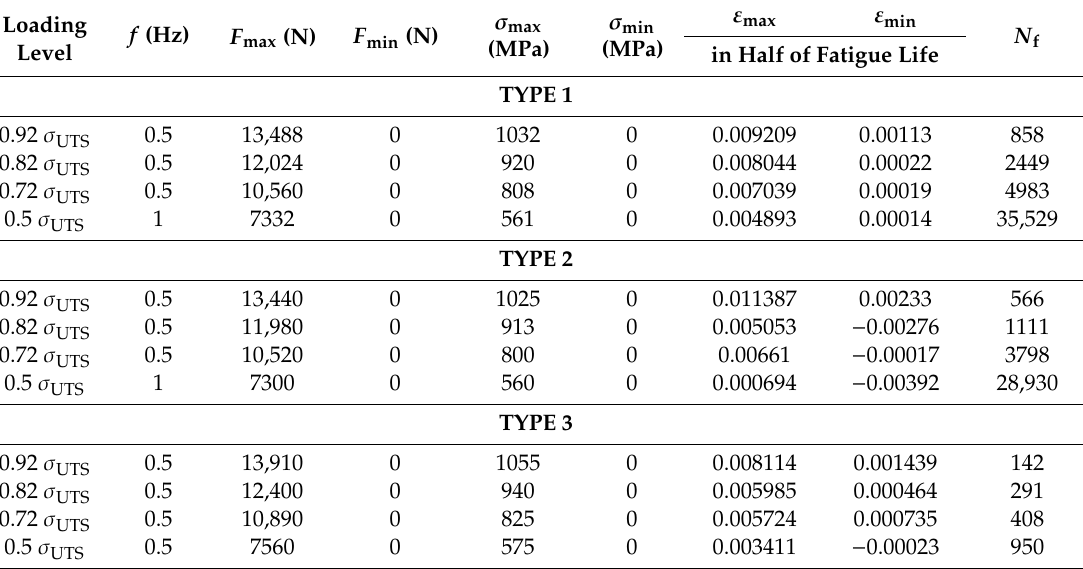
Table 5. List of parameters used during the fatigue test along with corresponding